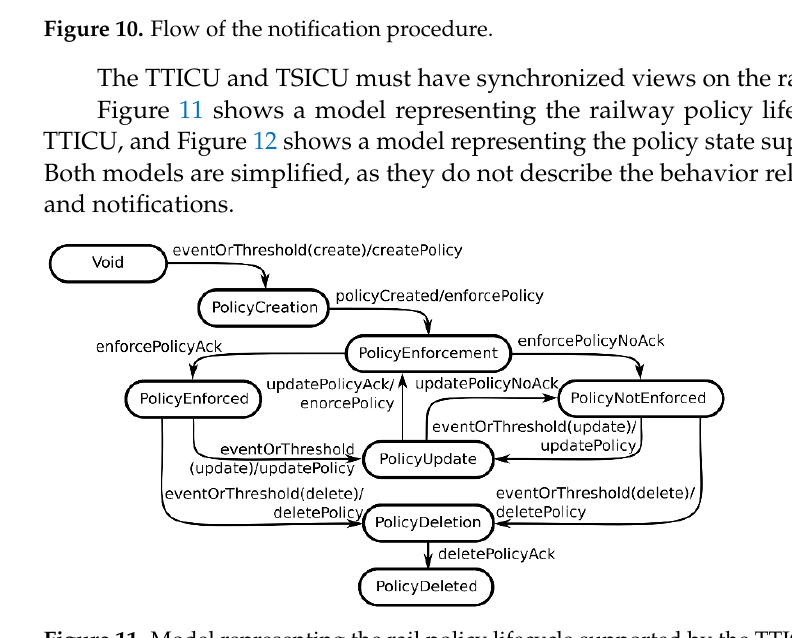
Figure 11. Model representing the rail policy lifecycle supported by the